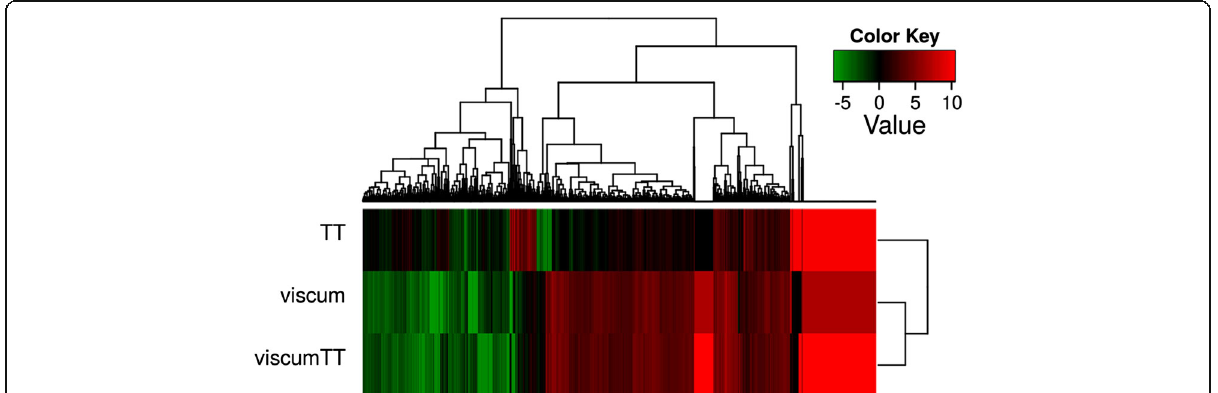
Fig. 1 ViscumTT alters the transcriptomic profile. TC-71 cells were incubated for 24 h with viscumTT, viscum or TT in ~ IC50 concentrations